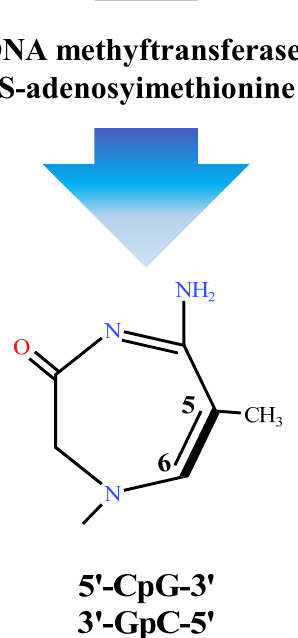
Figure 5. DNA methylation. Figure 5. DNA Figure 6 Cytosine DNA methylation is a stable epigenetic mark that is critical for diverse biological processes, including gene and transposon silencing, imprinting, and X chromosome inactivation. Our discovery and understanding of the pathways used to ac- curately target, maintain and modify DNA methylation pa tt erns reveal unexpected mech- anistic similarities between these organisms. Key roles for small RNAs, proteins with methylated DNA binding domains and DNA glycosylases in these processes have emerged. Drawing on insights from both plants and animals should deepen our under- standing of the regulation and biological signi fi cance of DNA methylation [130].